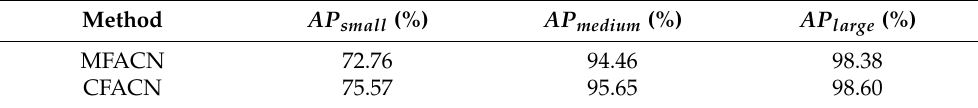
Table 3. The detection performance of MFACN and CFACN methods for different target